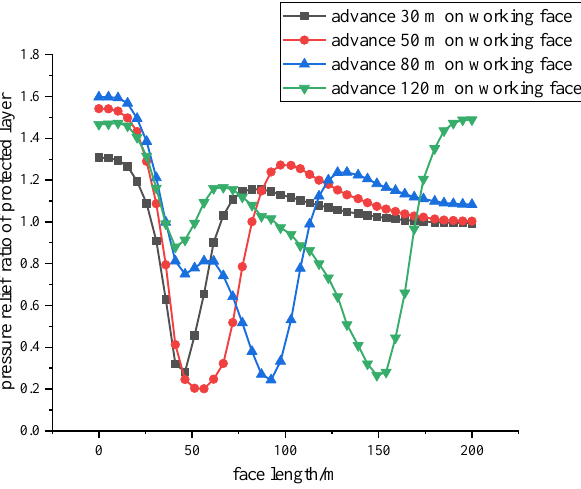
Figure 11. Pressure relief rate diagram of working face propulsion at different